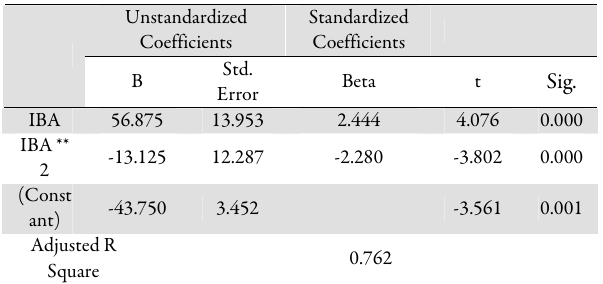
Tab. 3. Coefficients of regression on rooting of Cornelian cherry (Cornus mas L.) cuttings using